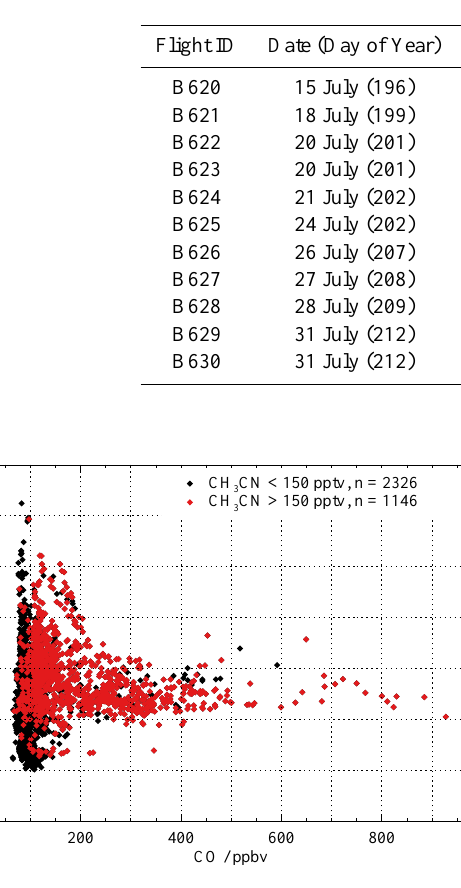
Table 1. Flight IDs, dates, and location of research flights made by the BAe-146 during the BORTAS aircraft measurement campaign in 2011. The relative locations of each flight are shown in Palmer et al. (2013).